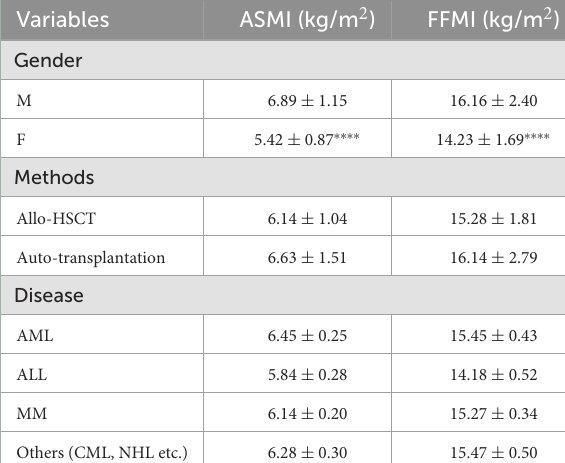
TABLE 2 Human body composition in patients with different